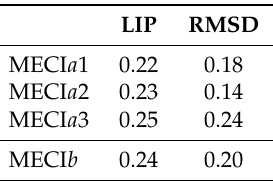
state for fixed C Phe =O ( II ) MECI geometries in NAPAH B ( II )